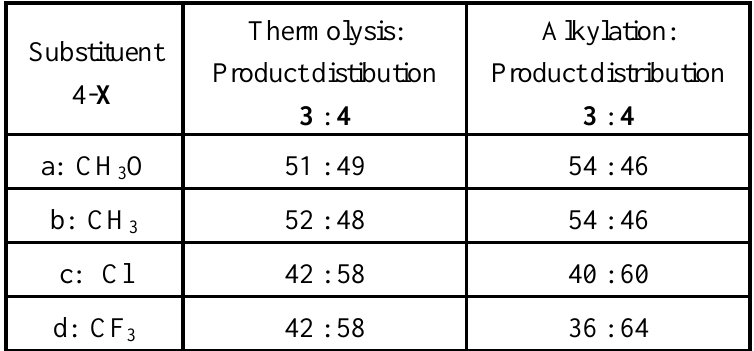
Table 2 . Distribution of regioisomers 3 and 4 on thermolysis of triazoles 2 and alkylation of triazoles 1 with methyl